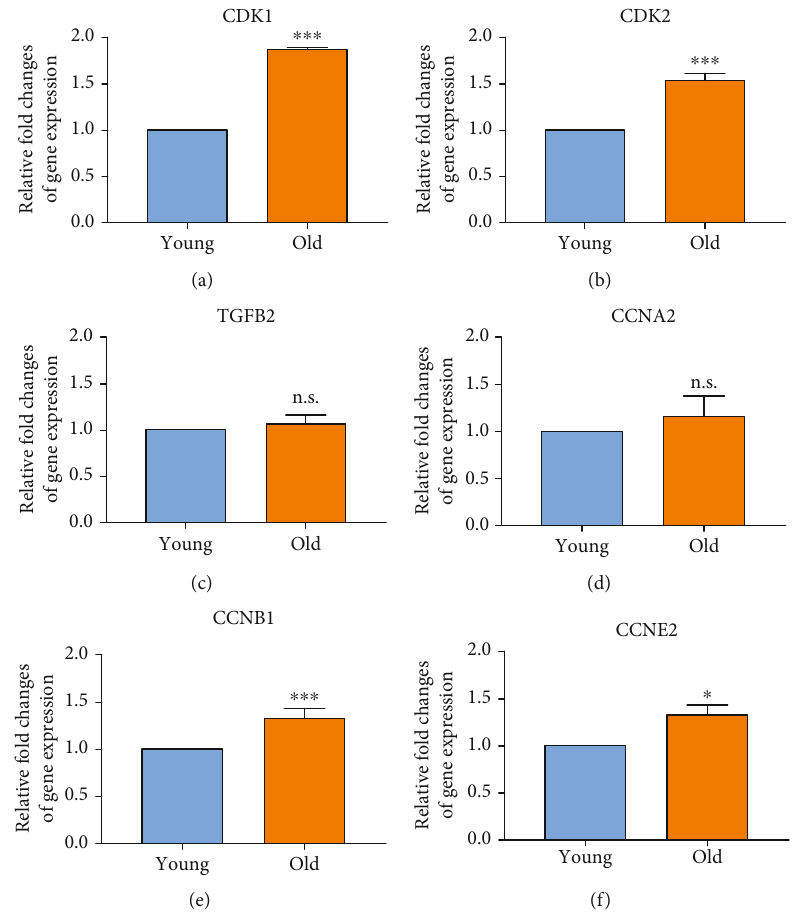
Figure 4: Changes of CDK family gene expression with replicative senescence in TMSCs. Changes in the expression of cellular senescence and cell cycle gene induced by replicative subculture were con fi rmed by quantitative RT-PCR (a) CDK1 , (b) CDK2 (c) TGFB2 , (d) CCNA2 , (e) CCNB1 , and (f) CCNE2 . The bar graph represents relative fold changes in gene expression, determined by cT value of each sample normalized to that of respective β -actin . The p values were considered statistically signi fi cant ( ∗∗∗ p < 0 : 001 , ∗ p < 0 : 05 ; n.s.: not signi fi